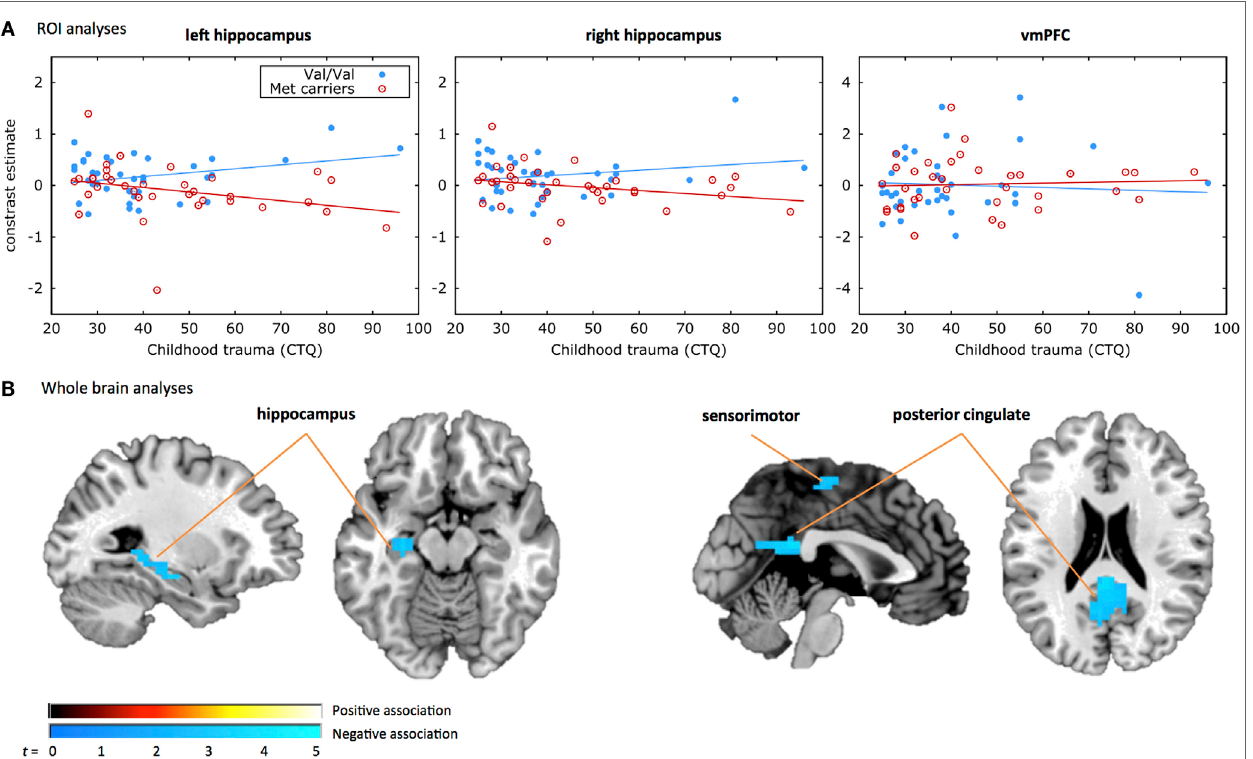
FigUre 1 | COMT by childhood trauma interaction . Displayed are the results from (a) the region of interest (ROI) analyses and (B) the whole brain analyses of the COMT genotype by childhood trauma interaction. (a) Shows the response inhibition-related activation in the three ROIs, i.e., left hippocampus (left), right hippocampus (middle), and ventromedial prefrontal cortex (vmPFC) on the y -axis plotted against the CTQ score on the x -axis. The filled blue dots represent individuals with the Val/Val genotype and the red open dots represent individuals carrying the Met allele. A significant COMT genotype by childhood trauma effect was observed in the left hippocampus, with less inhibition-related hippocampal activation with increasing levels of childhood trauma in the Met carrier group and more inhibition-related hippocampal activation with increasing levels of childhood trauma in the Val/Val group. (B) Shows the whole brain activation during the response inhibition task for the COMT genotype by childhood trauma effect. The positive association indicates that the Met carrier group shows more inhibition- related activation with increased rates of childhood trauma compared to the Val/Val group. The negative association indicates that the Met carrier group shows less inhibition-related activation with increased rates of childhood trauma compared to the Val/Val group. A significant COMT genotype by childhood trauma effect was observed in the hippocampus, sensorimotor, and posterior cingulate areas.